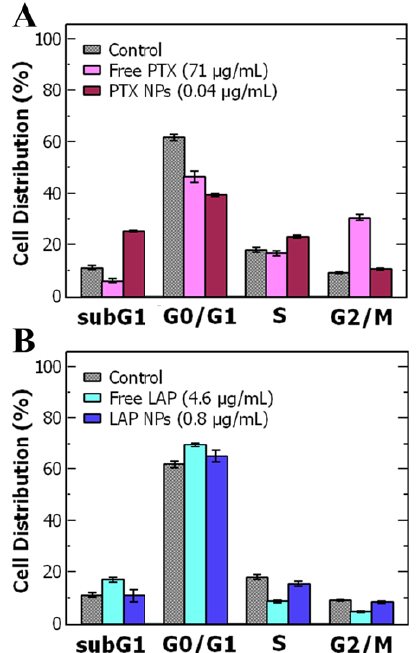
Figure 3. Cell cycle analysis of OVCA-432 cells from flow cytometry to compare free drug (in 2% v / v DMSO) and nanoparticle formulations for ( A ) paclitaxel (PTX) and ( B ) lapatinib (LAP). The graph shows the average ± standard deviation from 3 replicate wells.